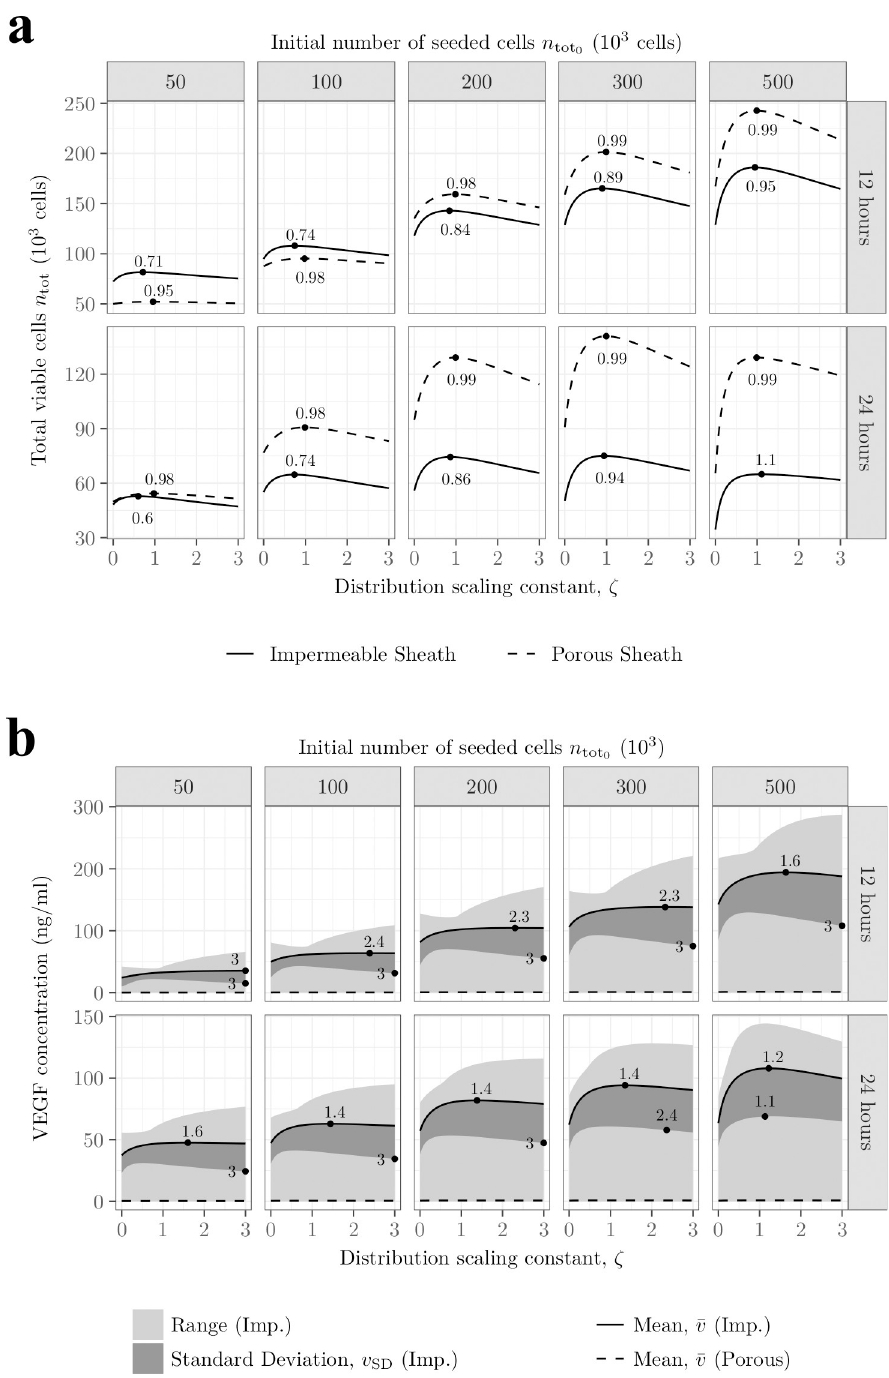
Fig 11. Seeding cells in the stump regions increases cell density and seeding cells in the central region increases VEGF concentration after 24h for an impermeable sheath. For a porous sheath, uniform seeding leads to maximal cell density . A) Total cell number and B) mean, standard deviation (dark grey areas) and ranges (light grey areas) of VEGF concentration, as functions of the repartition factor z and the initial total number of cells n 0,total , for an impermeable (continuous line) and a porous (dashed line) sheath, after 12 and 24 hours. Black dots indicate the repartition factor z yielding the highest total number of cells, i . e . argmax e . argmax z � v � ; and the highest standard deviation of VEGF concentration, i . e . argmax z � v � structure is approximated by an array of overlapping spheres (see Table 1) with a thickness T = 0.25mm and a porosity � =